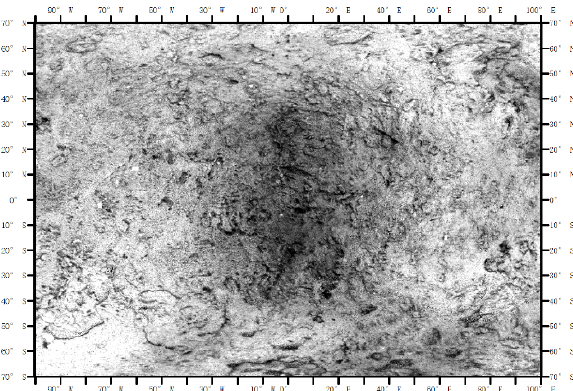
Figure 10. DOM between latitudes of 70 ° N and 70 °